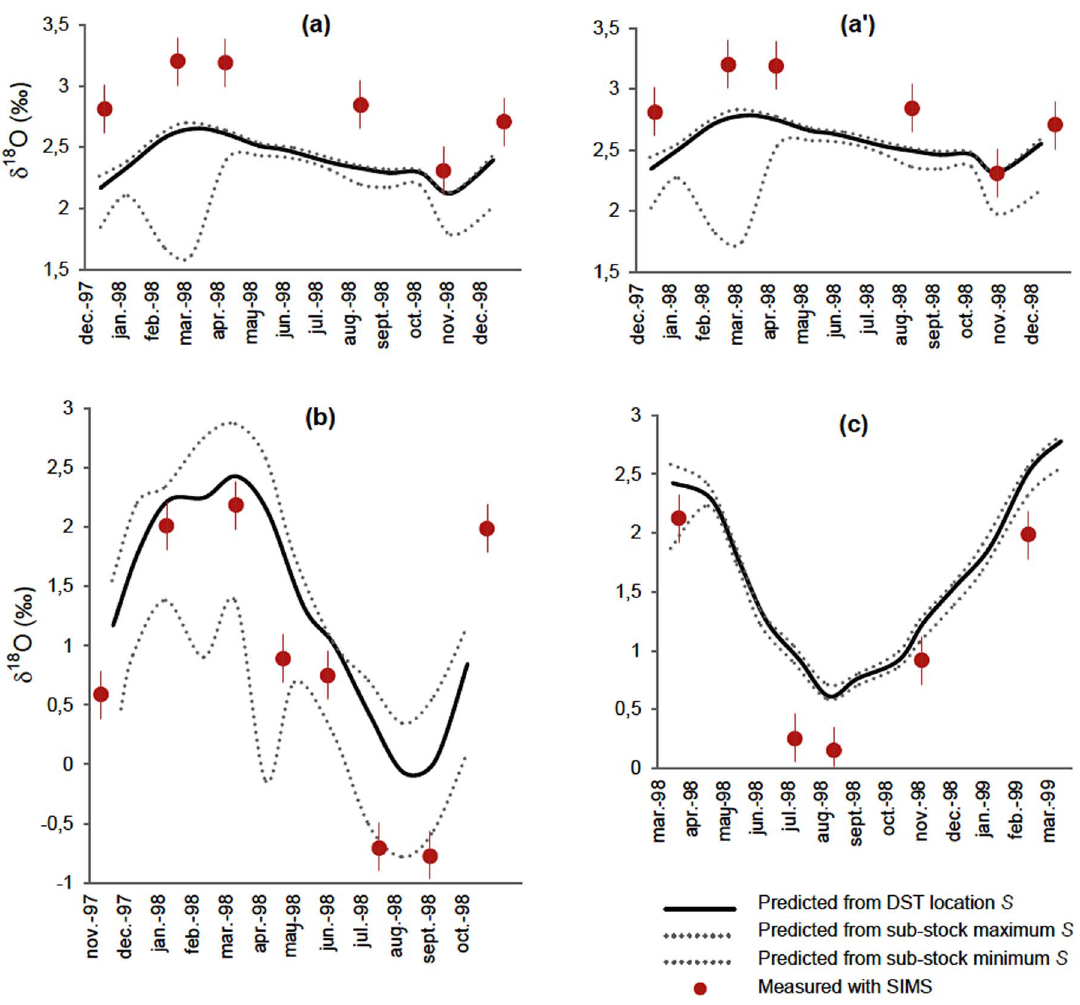
Figure 7. Uncertainty around salinity estimates do not explain d 18 O offsets. Potential errors due to salinity estimation from fish geolocation with GETM on the predictions of monthly d 18 O values for sub-stocks A (a), B (b) and C (c), when using the equation for inorganic aragonite (Kim et al. 2007). For sub-stock A, predictions using the equation for juvenile plaice (Geffen 2012) are provided for comparison (a’). Spots indicate successive intra-annual otolith d 18 O values (with vertical bars showing analytic error with SIMS) during DST recording time for a representative fish per sub-stock (cf. Fig. 5). Matching values predicted from in situ tag temperature data, combined either with corresponding individual daily GETM salinity estimates (black solid line), or with the minimum and maximum daily salinity GETM estimates obtained monthly over the full 3-year distribution range of the sub-stock (grey dotted lines).